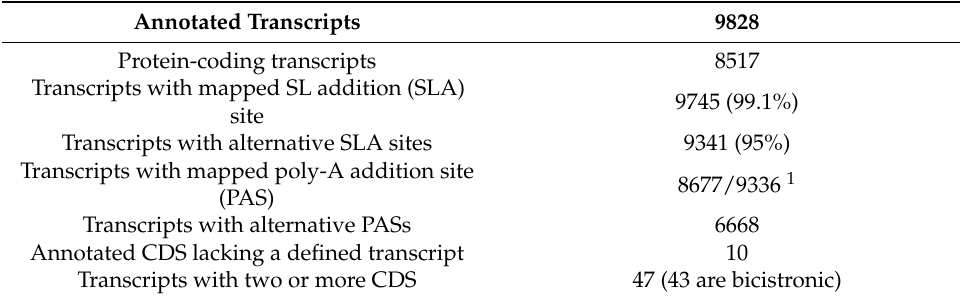
Table 2. The poly-A+ transcriptome of L. major Friedlin